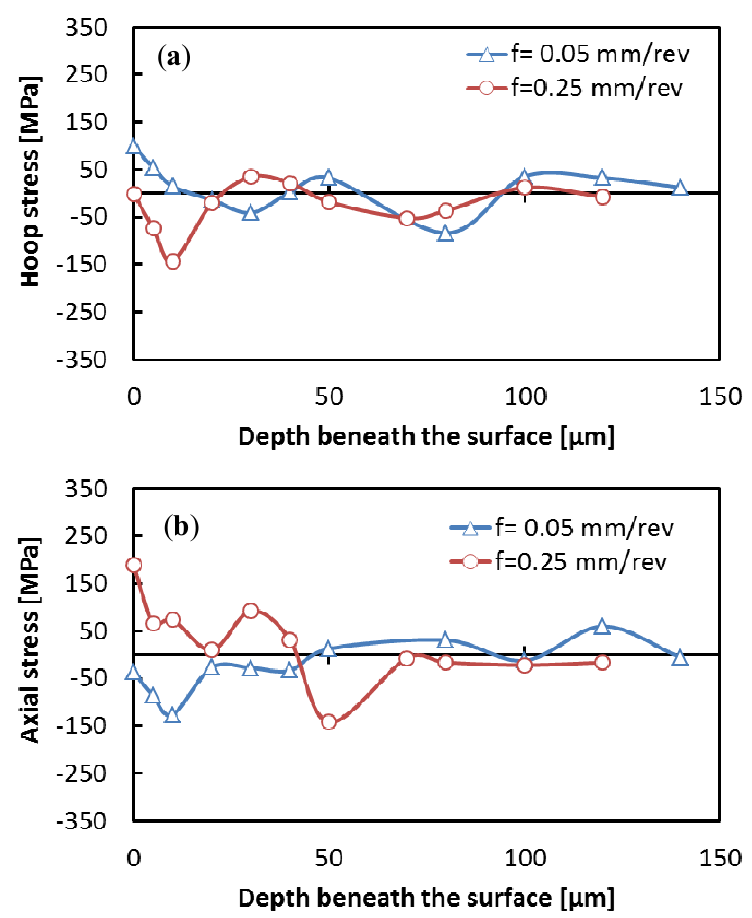
Figure 16. Effect of cutting speed on hoop ( a ) and axial (b ) residual stress distribution for cutting speed of 1000